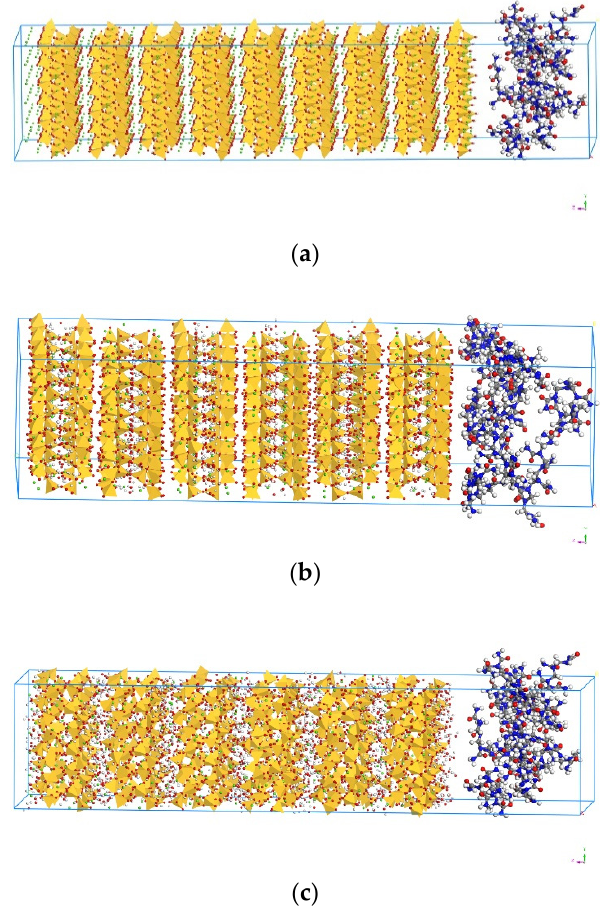
Figure 4. Molecular structure of Tobermorite-UF: ( a ) Molecular structure of T9-UF, ( b ) Molecular structure of T11-UF, ( c ) Molecular structure of T14-UF (Color legend: hydrogen H (white); calcium Ca (green); oxygen O (red); nitrogen N (blue) carbon C (grey); silica Si (yellow